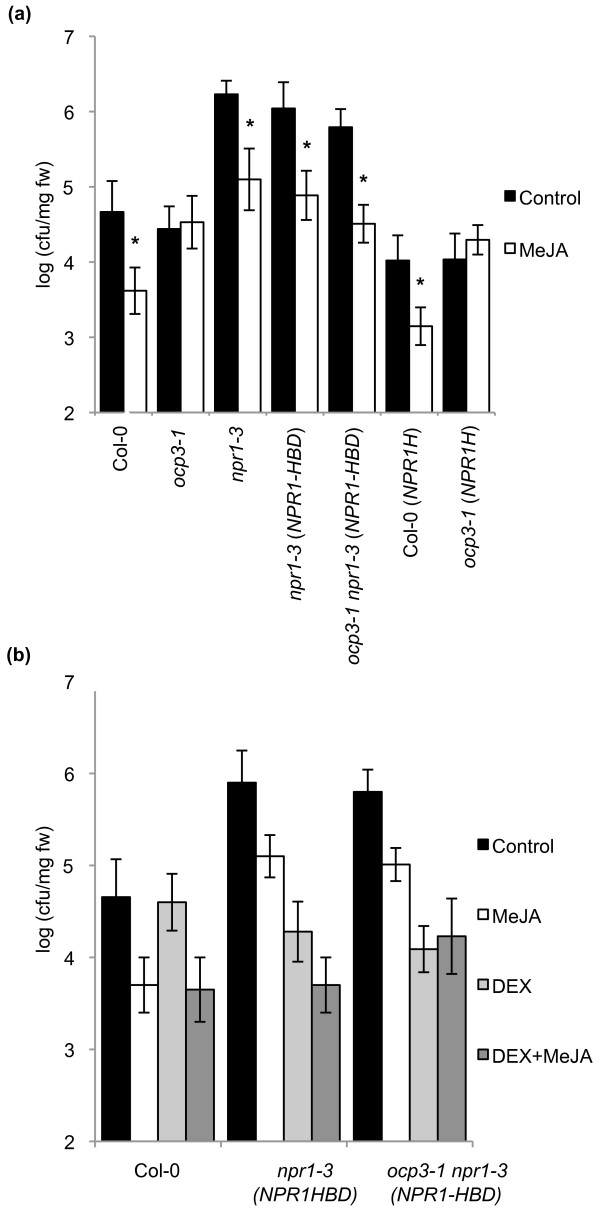
Overexpression of a cytosolic isoform of NPR1 (NPR1-HBD) restores the impaired JA-induced disease resistance in ocp3-1 plants while dexamethasone treatment eliminates this protective effect. (a) Two-week-old plants were treated by dipping with a solution of 10 mM MgSO4 (Control) or 50 μM MeJA. After two days, plants were challenge inoculated as described in Figure 3. Asterisks indicate significant difference from the control treatment (P < 0.05) using the Student's t test. (b) As in (a), plants were treated with 10 mM MgSO4 (Control), with 50 μM MeJA, with 5 μM dexamethasone (DEX) or with 50 μM MeJA plus 5 μM dexamethasone (DEX). The experiments were repeated three times with similar results.